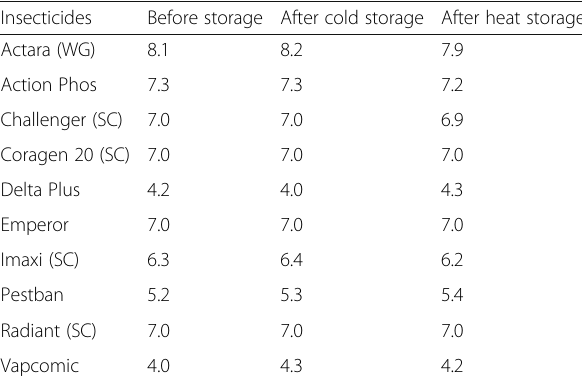
Table 3 pH of the examinedinsecticides before storage, after cold, and heat tropical storage